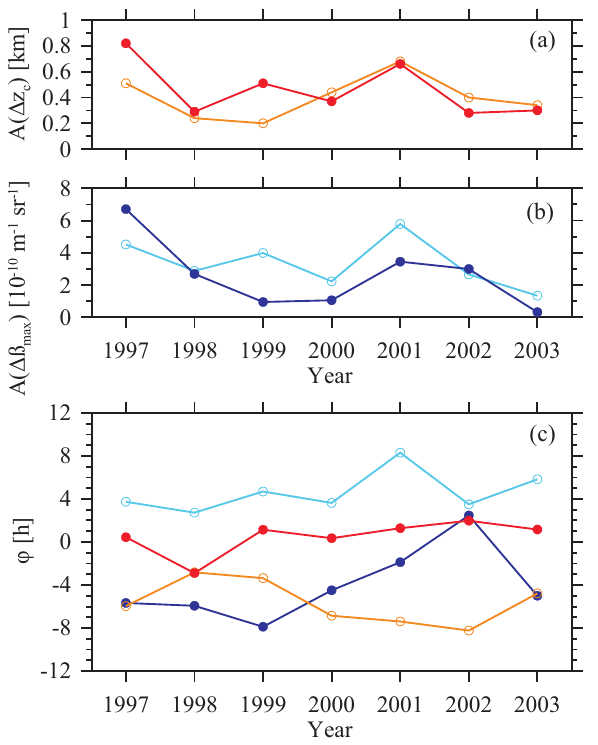
Fig. 5. Diurnal and semidiurnal wave parameters of NLC altitude and brightness above ALOMAR for each individual year: ampli- tudes ( a ) and ( b ) , and phases ( c ) of the harmonic fits shown in Fig. 4. Altitude: orange hollow circles (diurnal component), red filled cir- cles (semidiurnal component). Brightness: cyan hollow circles (di- urnal component), blue filled circles (semidiurnal